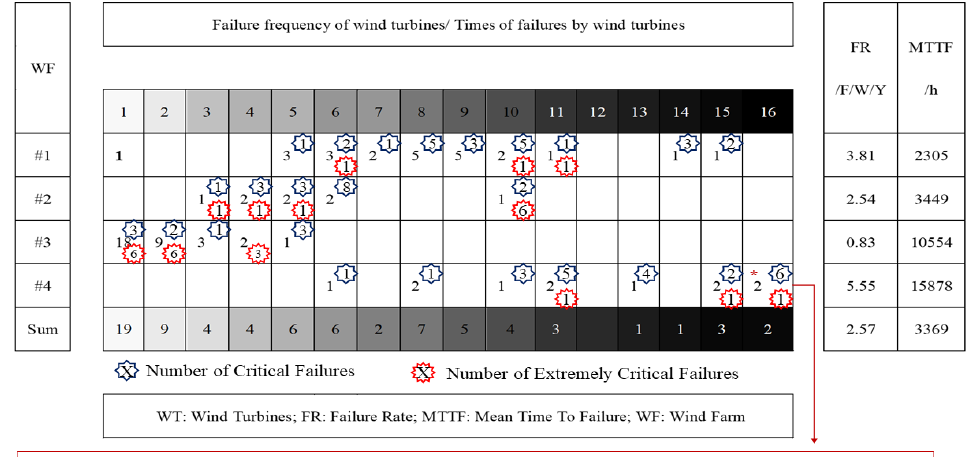
Figure 5. Failure criticality statistics by wind farm.